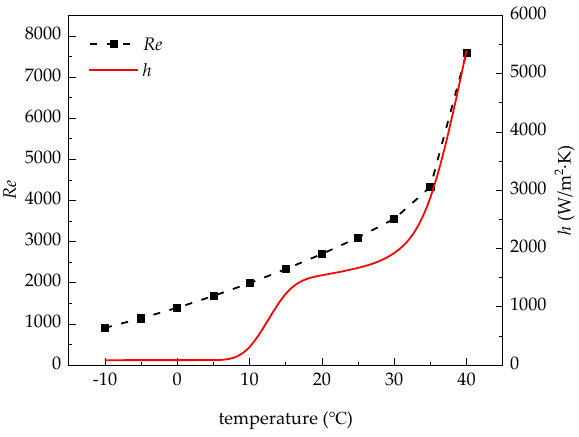
Figure 11. Re number and convection coe ffi cient of coolant with temperature.